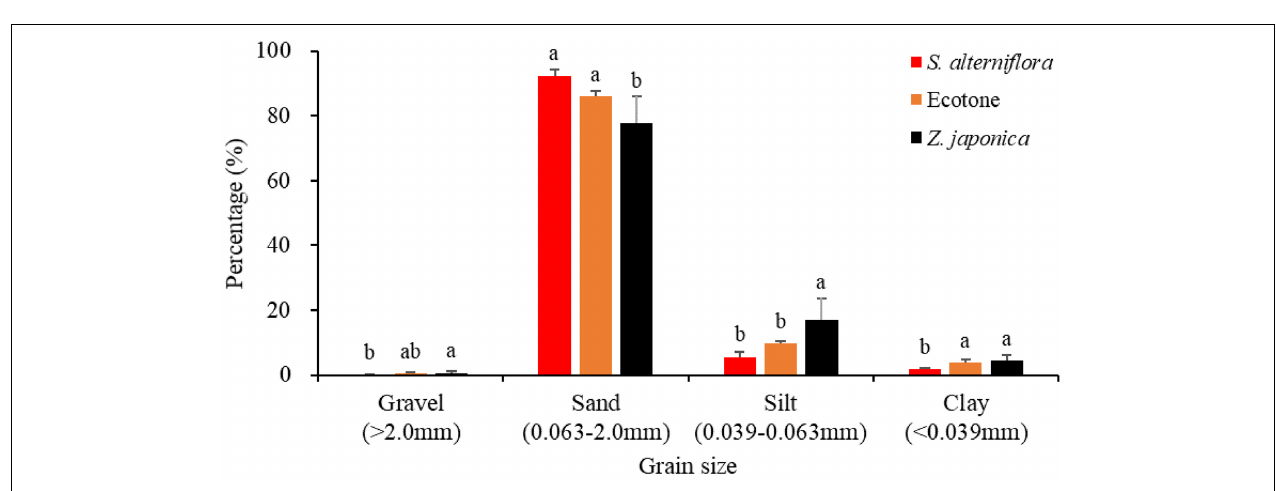
FIGURE 3 | Sediment grain sizes at the three regions. Values are mean ± SD. Different letters indicate significant difference between different regions at same size of grain.